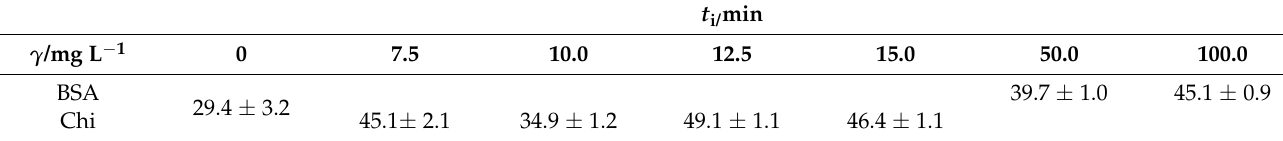
Table 2. Average induction times for crystalline phase formation ( t i ) obtained from pH vs. time curves from 3 measurements, with standard deviations in the precipitation systems con- taining TiNMs and different concentrations of bovine serum albumin (BSA) and chitosan